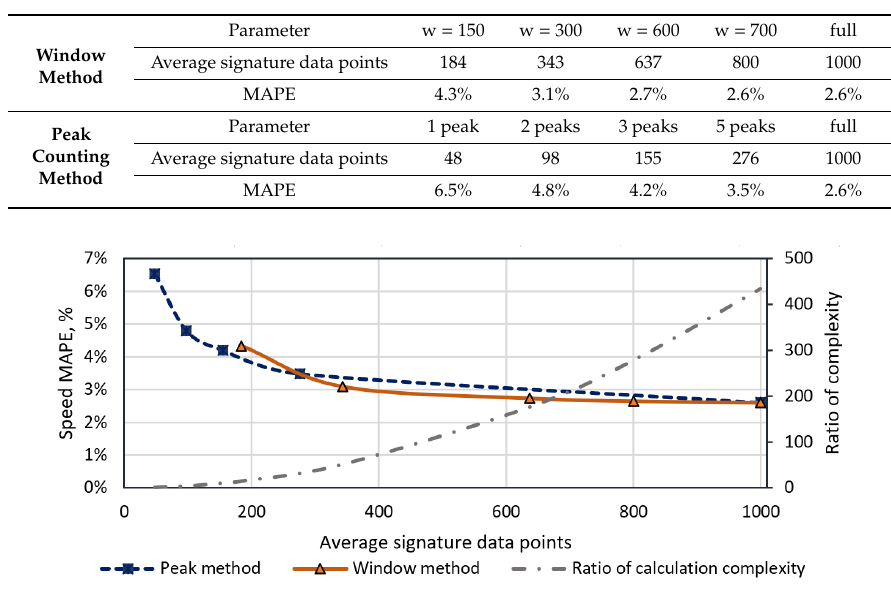
Figure 11. Comparison of signature cropping methods. Estimated speed MAPE of window and peak counting methods versus cropped data points of signature and relative computation complexity versus signature length.